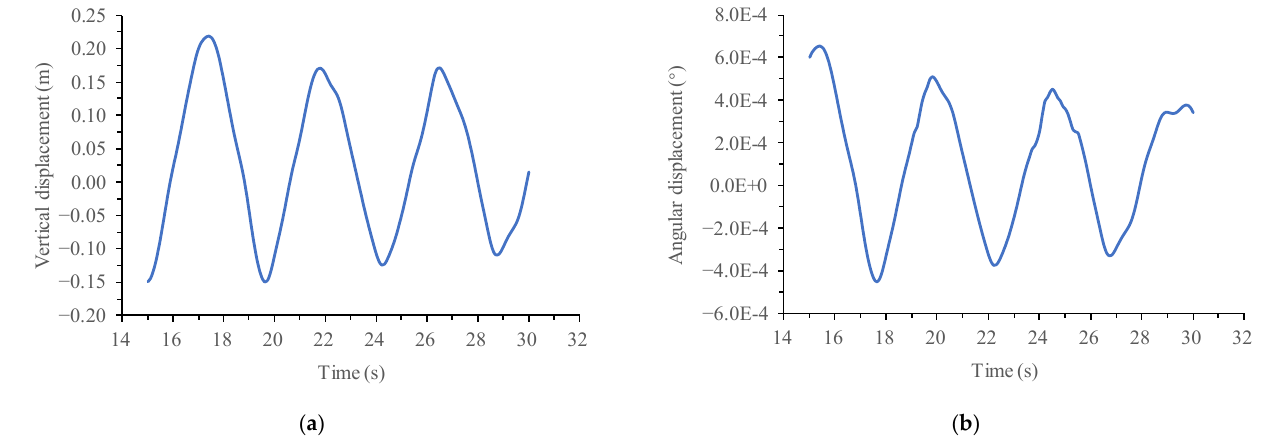
Figure 10. Time ‐ history curve of mid ‐ span displacement of Xiangshan Harbor Bridge when wind Figure 10. Time-history curve of mid-span displacement of Xiangshan Harbor Bridge when wind speed was 50 m/s. ( a ) Vertical displacement; ( b ) Angular displacement. speed was 50 m/s. ( a ) Vertical displacement; ( b ) Angular